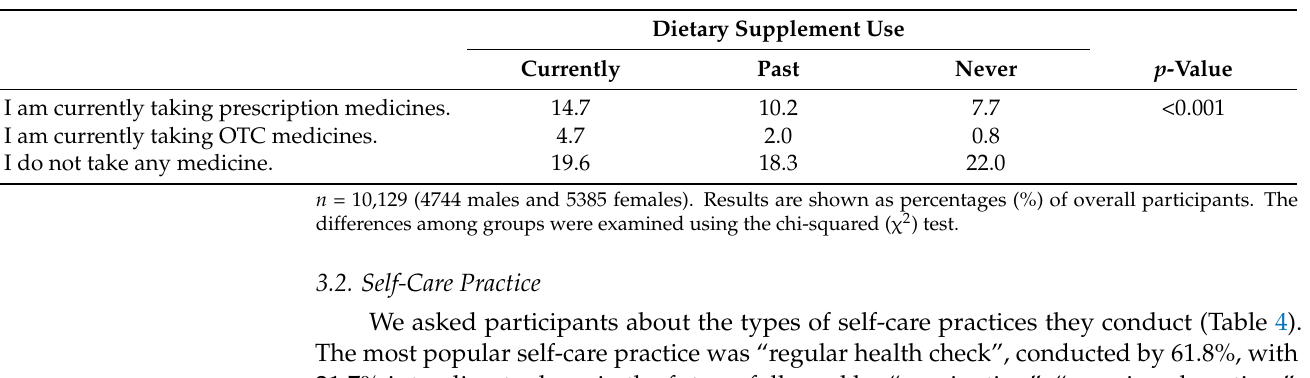
Table 3. Concomitant use of dietary supplements and